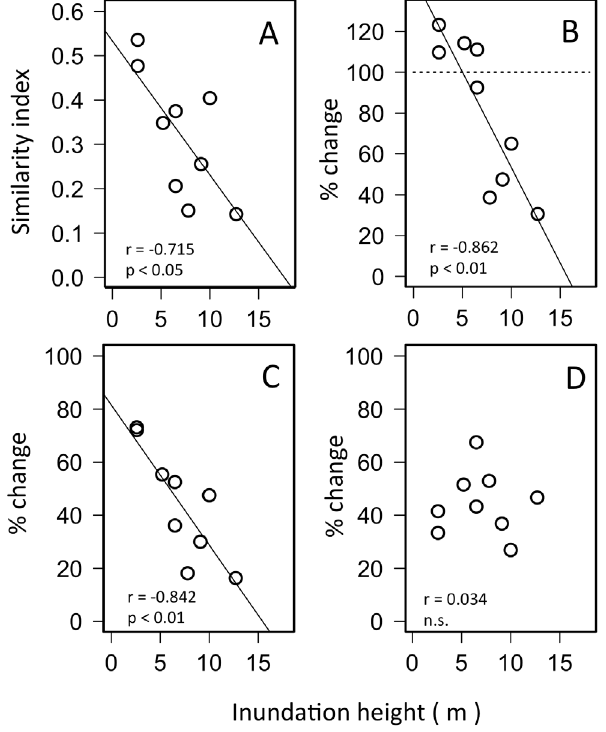
Figure 3. Jaccard similarity (see text) in taxon composition before and after the tsunami (A), percent changes in number of taxa (B), percent taxa remaining (C) and percent new taxa (D) plotted against inundation height of the tsunami. Correlation coefficients with significance levels are shown in each panel.